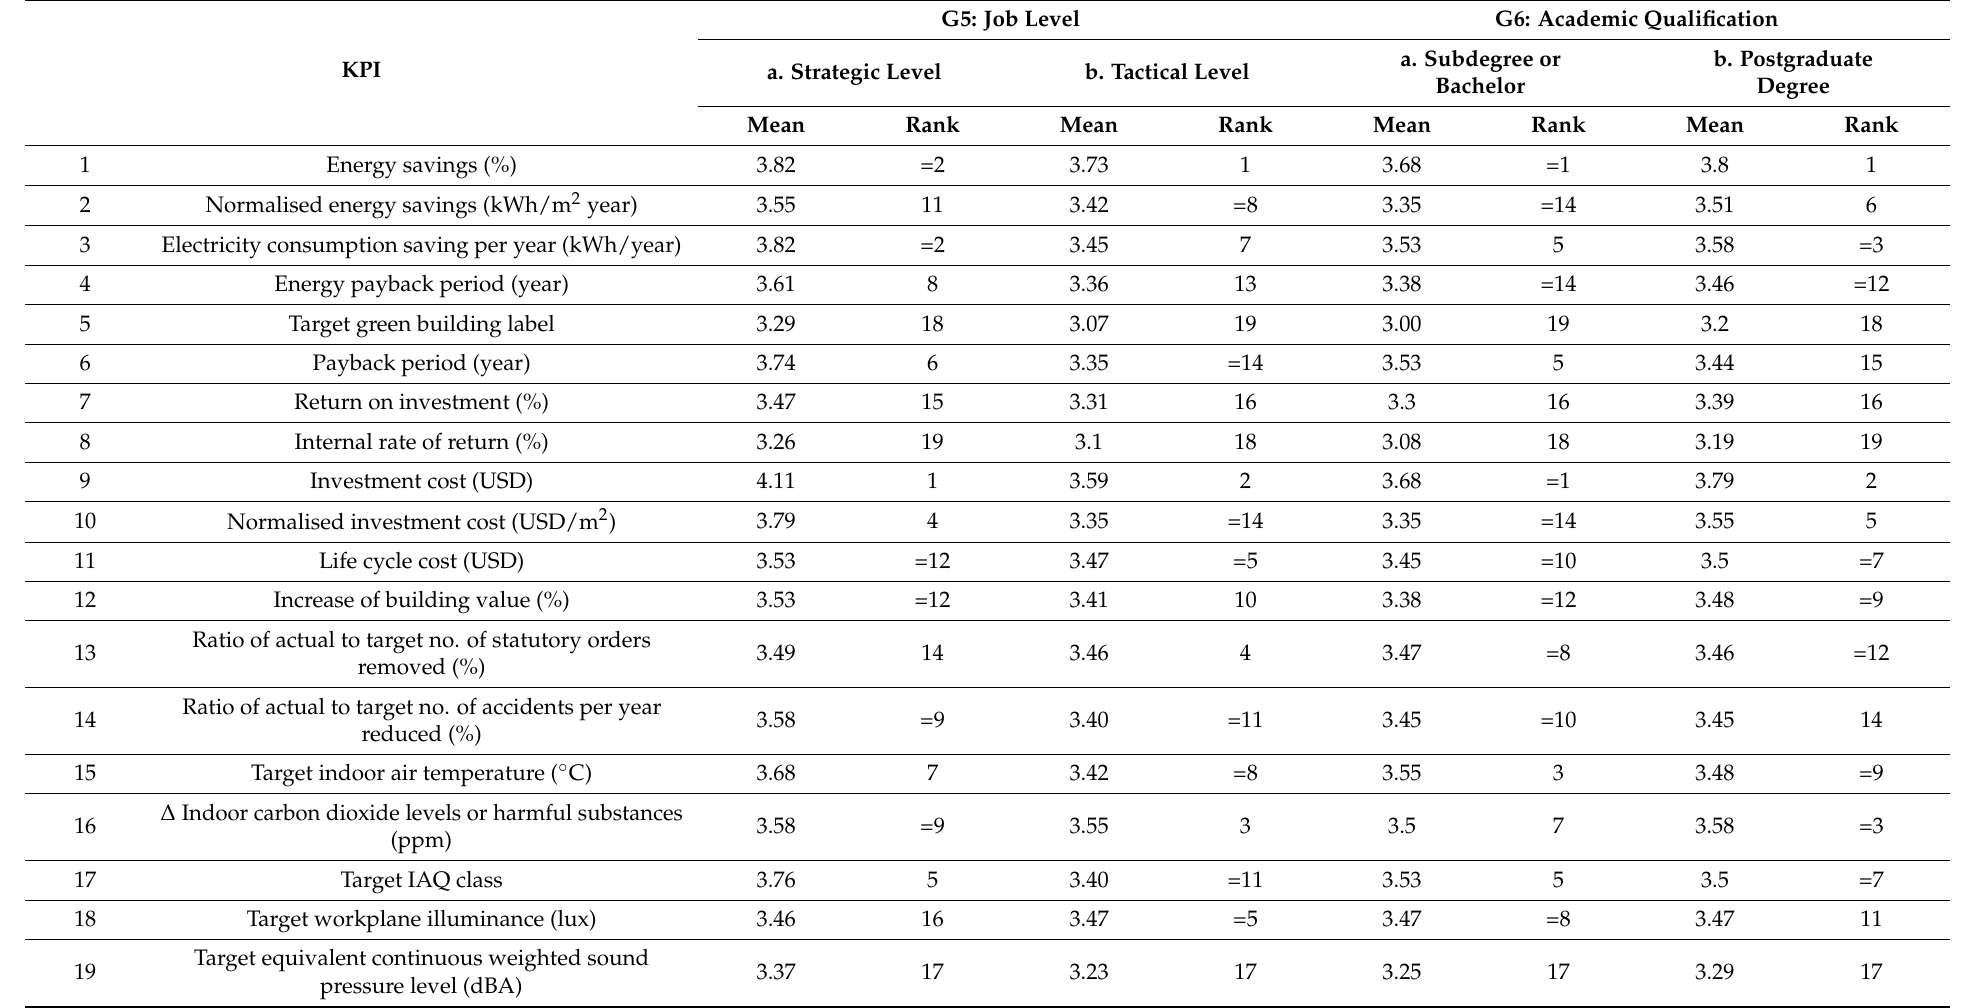
Table A3. Mean importance ratings and ranks of KPIs (G5 and